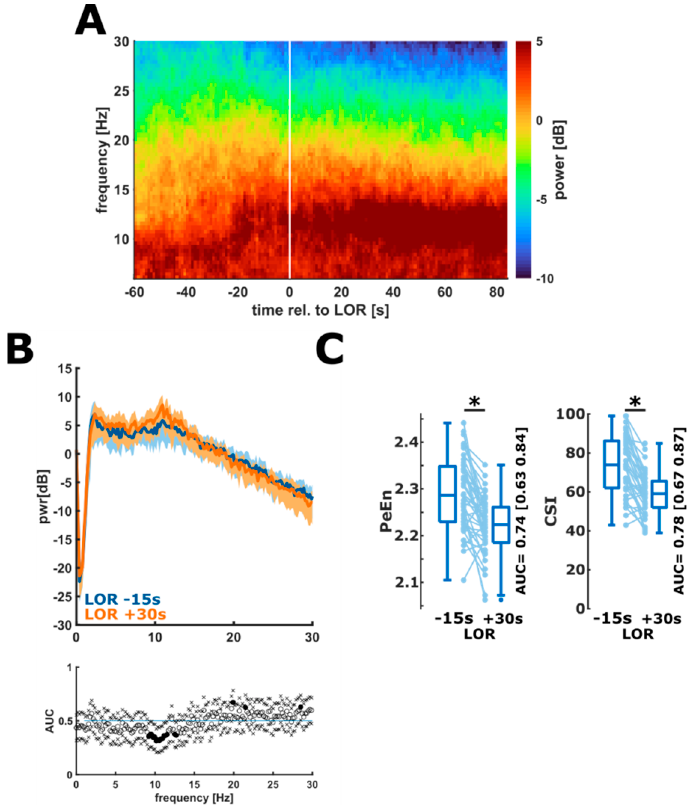
Figure 1. Changes in the spectral EEG representation and in processed EEG parameters during LOR. ( A ). Density spectral array (DSA) during the LOR episode. Over time, a strong alpha rhythm develops and the power in the faster frequencies decreases. ( B ) Comparison of the power spectral density 15 s before LOR (blue) to 30 s after LOR (orange). After LOR, the power in the alpha frequencies was significantly higher and there was power in the higher (beta) frequencies as indicated by the black dots in the AUC plot. ( C ) PeEn (left) significantly (*) and strongly decreased during LOR ( p < 0.001, g = 0.94 (0.65 1.8) and the performance to separate responsiveness from unresponsiveness was “ fair ” (AUC = 0.74 (0.63 0.84)). CSI (right) significantly and strongly decreased during LOR ( p < 0.001, g = 1.13 (0.85 1.51)) and the performance of the CSI to separate responsiveness from un responsiveness was “ fair ” (AUC = 0.78 (0.67 0.87)).